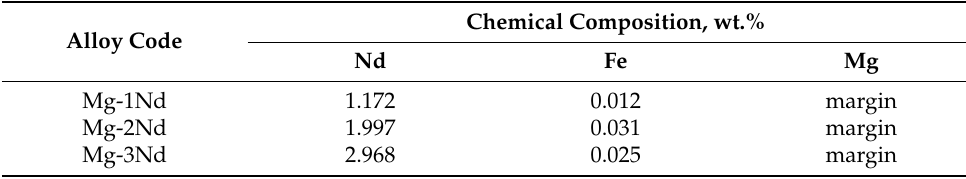
Table 1. Measured composition of the alloy. Alloy Code